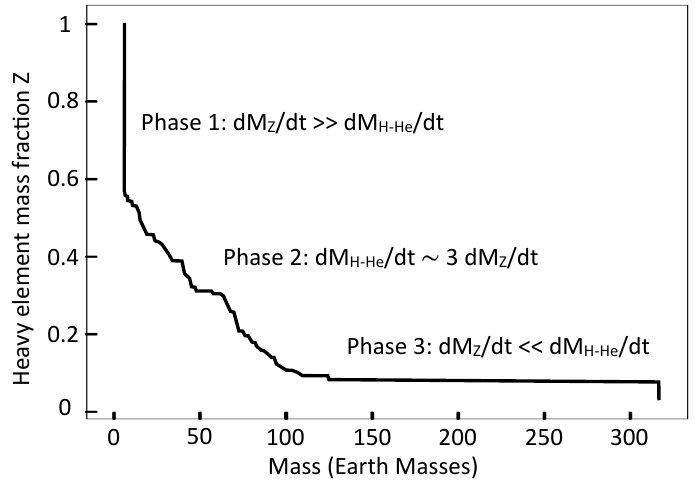
Figure 8. Distribution of the heavy-element mass fraction in Jupiter’s interior obtained by formation models. The model assumes that Jupiter is formed in different stages and the core is formed by pebble accretion followed by planetesimal accretion and finally rapid gas accretion [106,152,153]. Figure adapted from